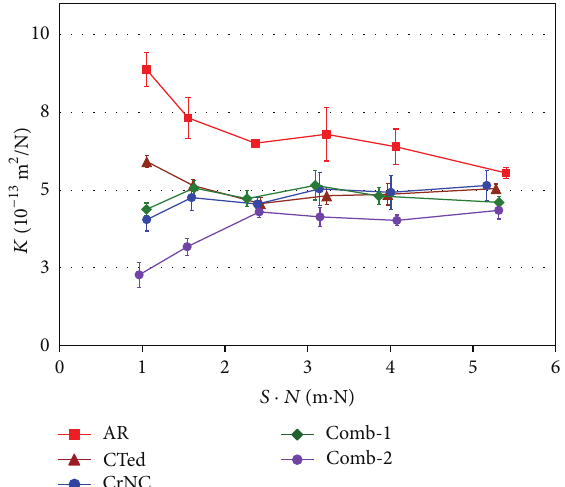
Figure 6: Wear rate versus sliding distance multiplied by the contact